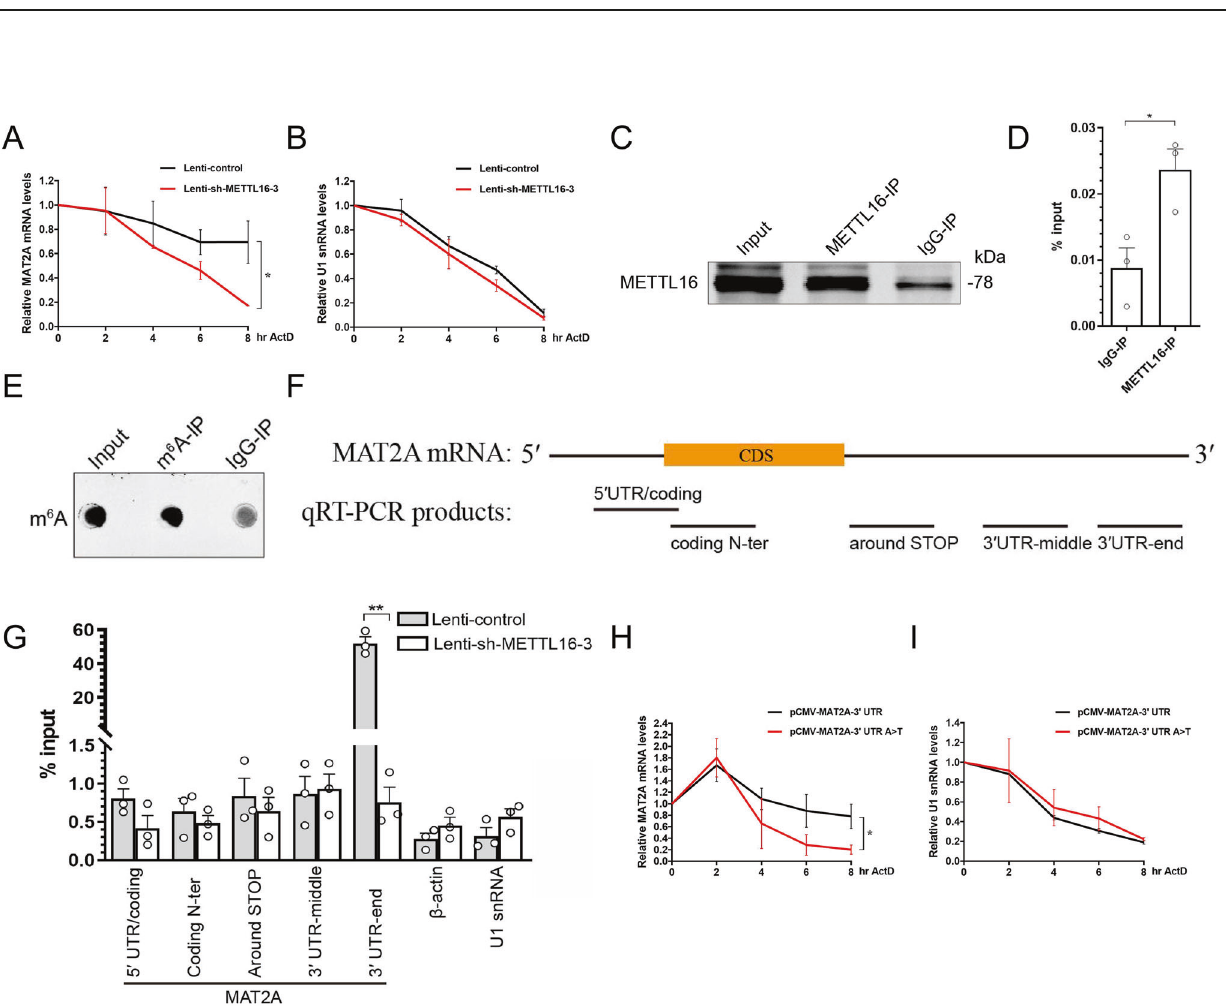
Fig. 5 Overexpression of MAT2A in hippocampi improves the hippocampal learning and memory disrupted by METTL16 knockdown. A Representative Golgi-Cox impregnated spines in the hippocampi of the AAV-sh-M16 + ctrl and AAV-sh-M16 + OE-MAT2A group; Scale bars = 10 μ m. B , C Quanti fi cation of the spine density ( B ) and the percentage of tin spine, fi lopodia spine, mushroom-like spine, and stubby spine ( C ) in the hippocampi of the two groups of mice ( n = 36 neurons from 6 mice per group). D Quanti fi cation of the spine density of mushroom-like and stubby spine in the hippocampi of the two groups of mice ( n = 36 neurons from 6 mice per group). E , F Representative images ( E ) and quanti fi cation of Drebrin, PSD95, and Syp ( F ) in the hippocampi of the two groups of mice were tested by western blotting ( n = 5). G , H Representative IHC images ( G ) and quanti fi cation of Drebrin, PSD95, and Syp ( H ) in the hippocampi of the two groups of mice ( n = 5); Scale bars = 500 μ m. I , J Representative images ( I ) and quanti fi cation of Drebrin, PSD95, and Syp ( J ) in the HT22 cells of the Lenti-sh- M16 + vec group ( n = 4) and Lenti-sh-M16 + OE-MAT2A group ( n = 4) tested by western blotting. K – N Entries in new arm ( K ), time in new arm ( L ), latency 1st entrance to new arm ( M ), and total distance ( N ) of mice in the AAV-sh-M16 + ctrl ( n = 9) and AAV-sh-M16 + OE-MAT2A group ( n = 9) were tested in Y-maze test. O – Q Discrimination index (DI) for new objects of mice in the AAV-sh-M16 + ctrl ( n = 9) and AAV-sh-M16 + OE- MAT2A group ( n = 9) was tested in 2 h ( P ) and 24 h ( Q ) after excluding the mice ’ s preference for object location ( O ) in the ORT experiment. R , S Average velocity ( R ) and latency to fi nd the platform ( S ) of mice in the AAV-sh-M16 + ctrl ( n = 9) and AAV-sh-M16 + OE-MAT2A group ( n = 9) were explored in the visible platform phase of MWM. T Latency to fi nd the platform of mice in the AAV-sh-M16 + ctrl ( n = 9) and AAV-sh- M16 + OE-MAT2A group ( n = 9) were explored in the training trials phase of MWM. U , V Number of platform crossings ( U ) and time in target quadrants ( V ) of mice in the AAV-sh-M16 + ctrl ( n = 9) and AAV-sh-M16 + OE-MAT2A group ( n = 9) were explored in the probe trial phase of